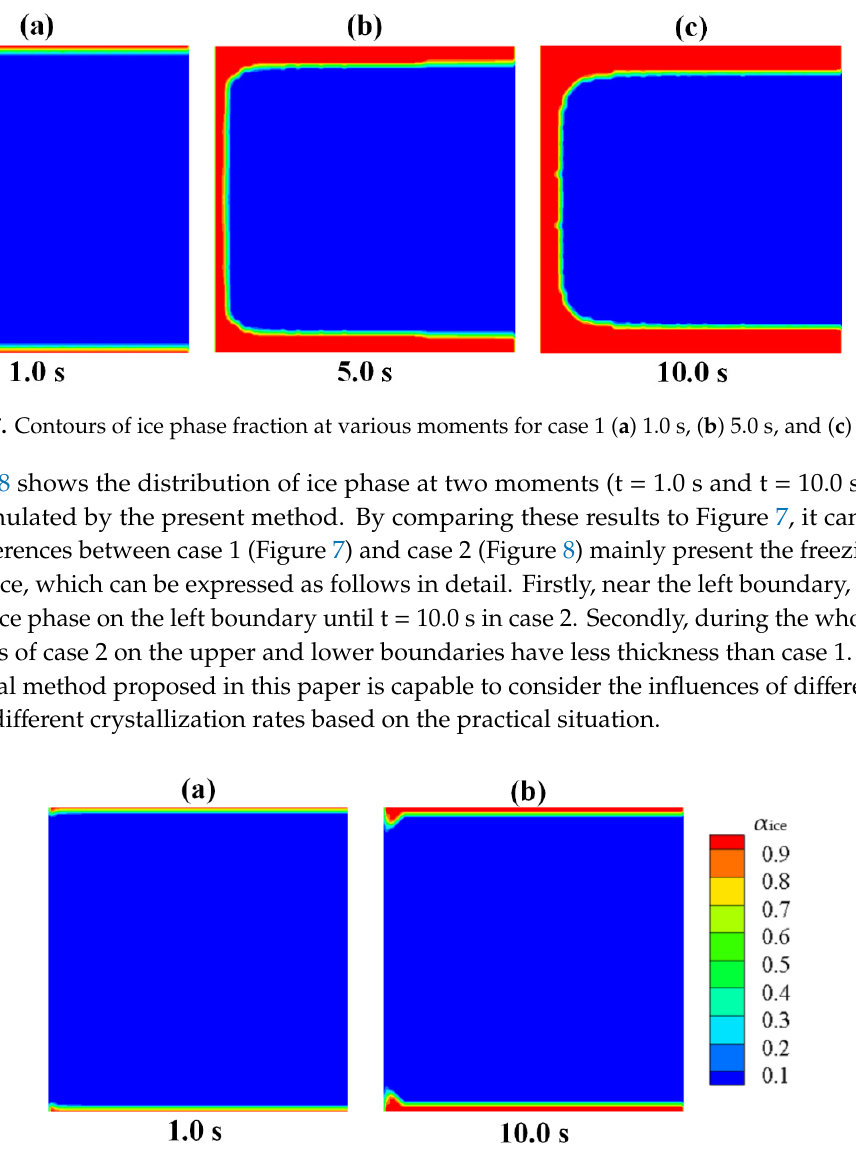
Figure 9. Comparison of temperature distribution (K) in both cases at t = 10.0 s ( a ) Case 1 and ( b ) Case 2. 3.2.2. Interaction of Fluid Field and Ice Phase In this section, the interaction between ice growth and fluid flow (case 3, 4, 5, and 6) is studied. For the practical situation, the cooling effect of the solid wall may be generally stronger than the formation water, which possibly causes the existence of the frozen ice at the initial moment of the displacement flow process. Furthermore, depending on the different conditions, the distributions of the initial frozen ice should be different. Therefore, four test cases with different initial ice phase are designed to study the displacement flow process with the growth of ice phase. The boundary conditions for case 3, 4, 5, and 6 are listed in Table 4. The shape coefficients of nucleation α ey in the fluid domain, on the ice and on the wall boundary are 1.0, 0.1, and 0.0001, respectively. Table 4. The settings of the boundary conditions (Case 3, 4, 5, 6). Boundary